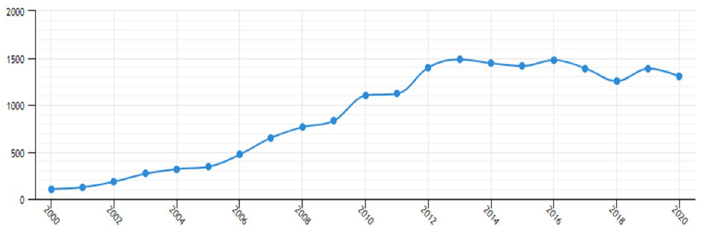
Fig 1. Academic research trends in folk art universities. Source: https://www.cnki.net/.